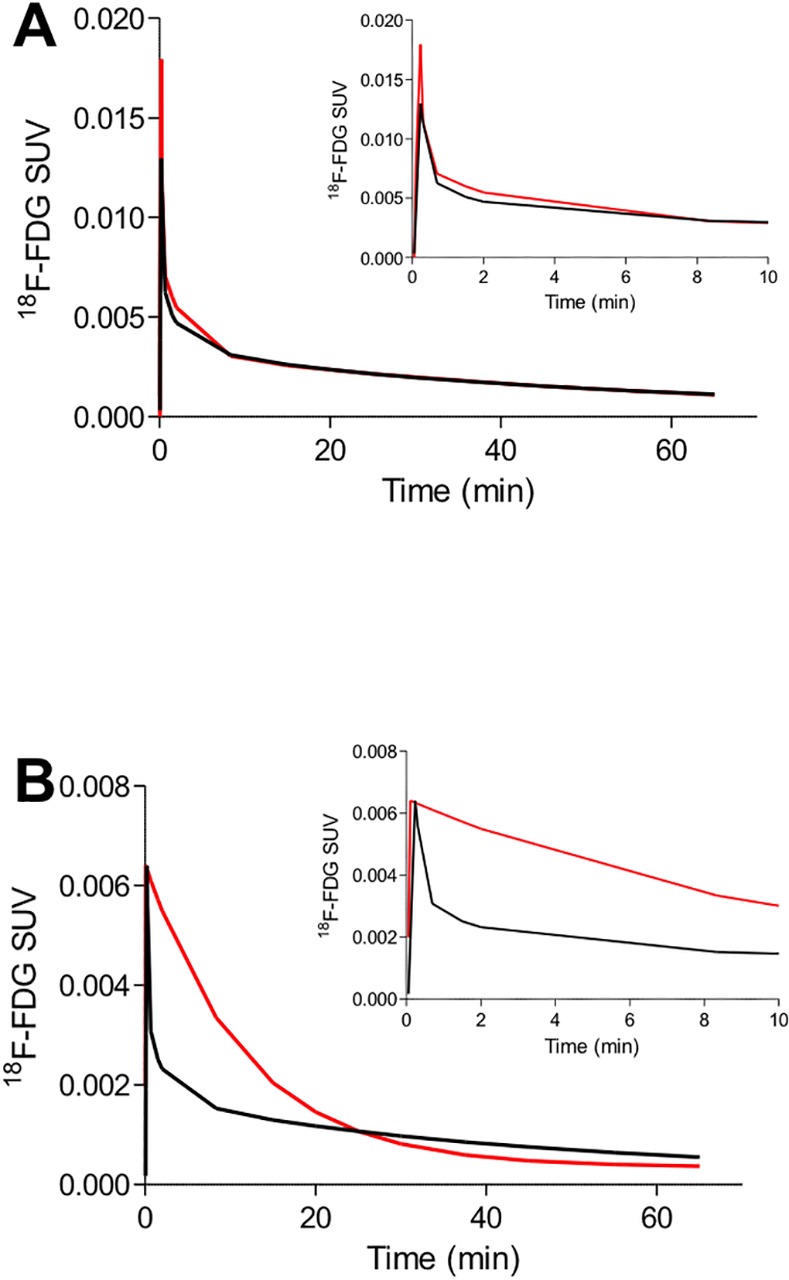
AIF (red) and SAIF (black) in two non-fasting mice.(A) Example of SAIF curve which is very similar to the blood reference curve (m17464). This SAIF is representative of the majority of the curves obtained in this study. There is however a significant number of AIF curves whose shape is incorrectly estimated by SAIF. (B) Example of AIF curve whose shape is incorrectly estimated by SAIF (m10911). One of the possible reasons is the difficulty of obtaining a reproducible bolus in the small tail vessels of mice. The insets magnify the first 10 minutes of the input functions.